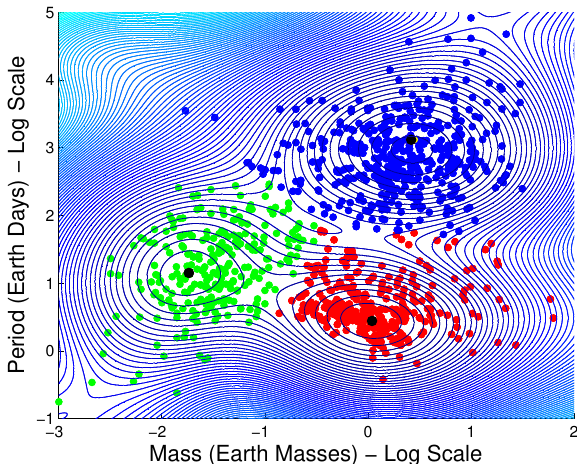
Figure 7. QC clustering applied to exoplanet